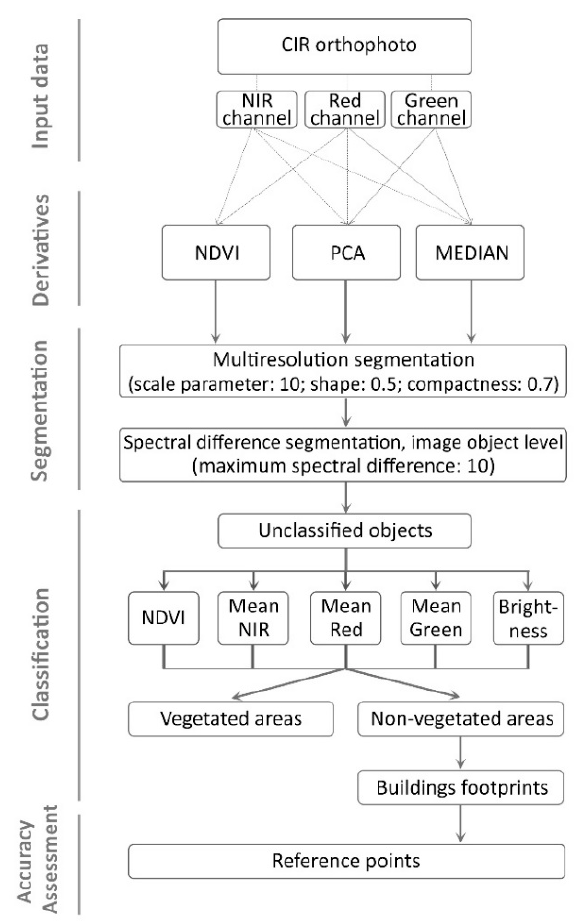
Figure 5. Stages of the GEOBIA building segmentation and classification in eCognition software (Trimble Geospatial); 1 —input data: CIR orthophoto; 2 —multiresolution segmentation; 3 —spectral difference segmentation; 4 —classification: buildings class.